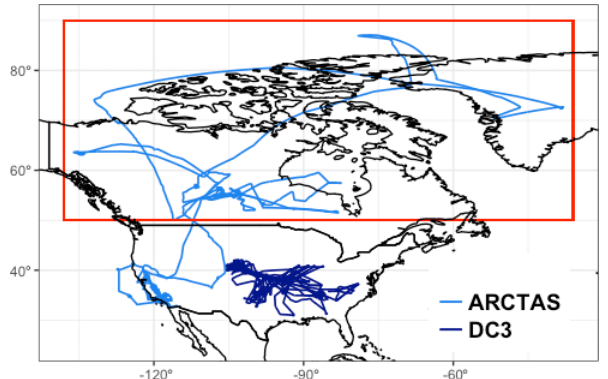
Figure 1. Flight tracks of the ARCTAS and DC3 aircraft cam- paigns. The red box indicates the boreal region of the ARCTAS flights used